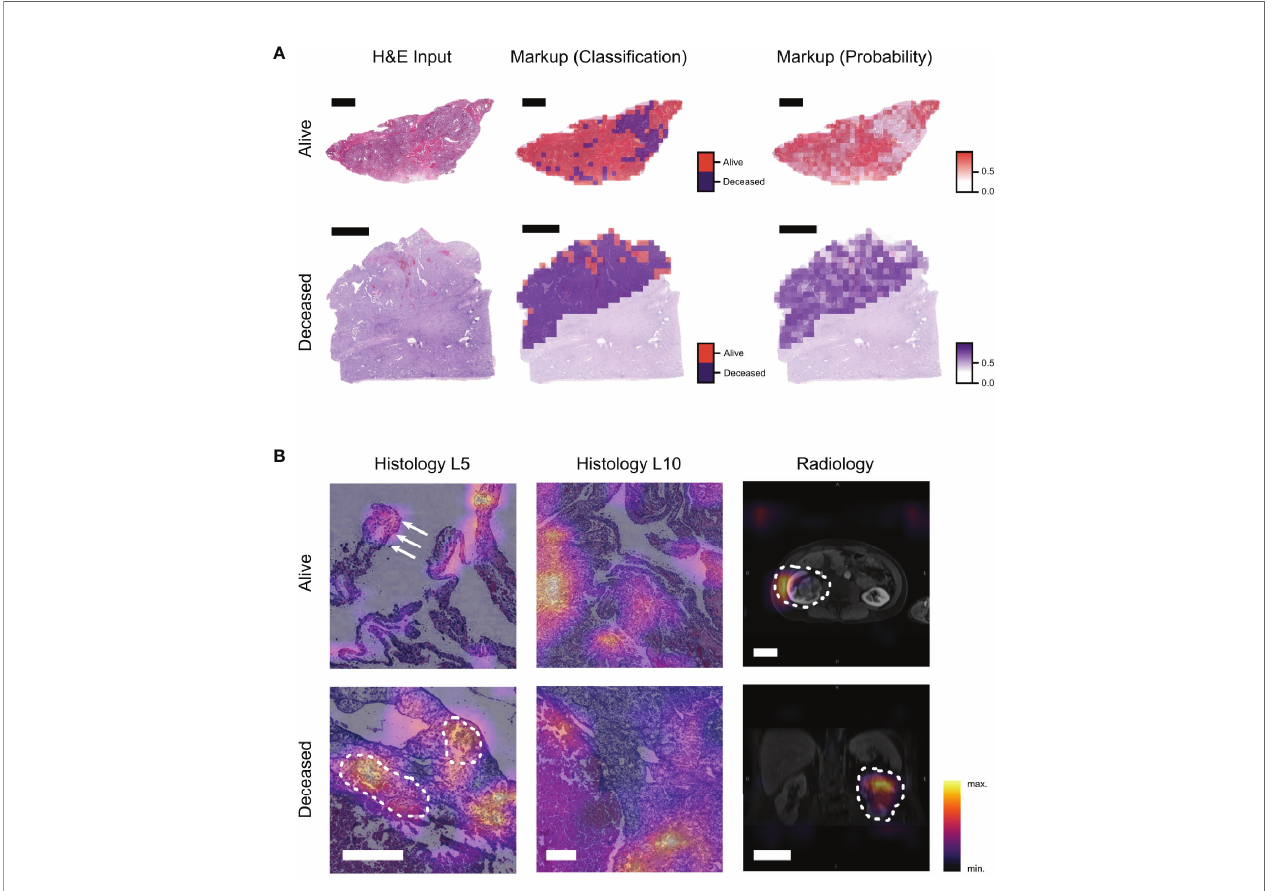
FIGURE 4 | Visualization techniques show image regions important for the prediction and their contribution to the MMDLM. (A) Example of a visualization approach to display the classi fi cation result of a unimodal histopathology model (ResNet18 — Level 5). The input WSI as well as two different markup images are displayed. Markup all denotes the distinction between tiles classi fi ed as alive or deceased. Markup class denotes the prediction certainty within the majority class (scalebar top row: 4 mm, scalebar bottom row: 5 mm). (B) CAMs of the MMDLM are shown. Different features associated with low-risk (alive) and high-risk (deceased) are highlighted. In the low-risk example, clear cell morphology as well as papillary tumor appearance (arrows) can be observed. In the high-risk example, tumor vasculature and bleeding can be observed (dotted line) (scalebar histology: 250 µm, scalebar radiology: 5